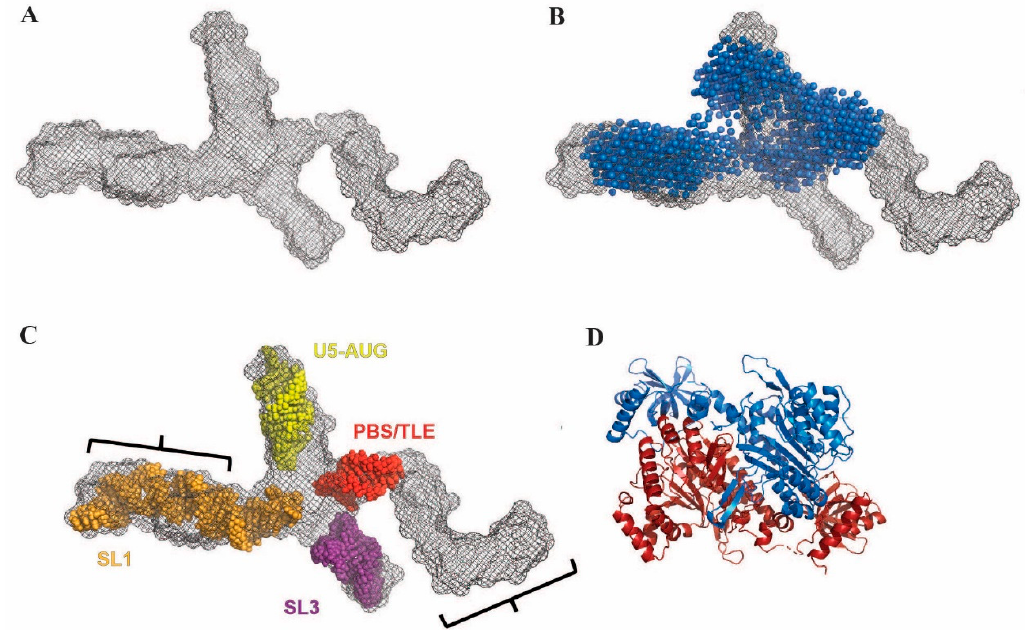
Figure 4. SAXS analysis of the UTR 240 ( Δ DIS). ( A ) SAXS envelope of the UTR 240 ( Δ DIS) RNA (grey mesh). ( B ) Alignment of the UTR 240 ( Δ DIS) with the envelope for UTR 240 ( Δ DIS, Δ PBS/TLE) (blue spheres). ( C ) Each of the individual helices (PBS/TLE, red; U5-AUG, yellow; SL1, orange; SL3, purple) from a previously reported NMR structure [38] fit into specific regions of the UTR 240 ( Δ DIS) SAXS envelope. ( D ) LysRS dimer crystal structure depicted at the same scale as the SAXS data with one monomer in red and the other in blue. Black brackets indicate approximate locations of LysRS binding sites determined by crosslinking.